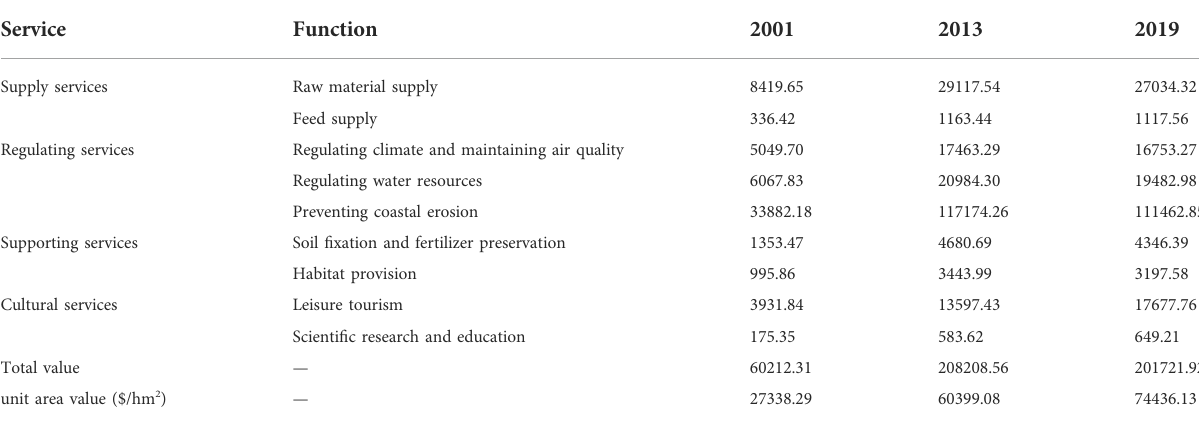
TABLE 3 The monetary values of China ’ s mangrove ecosystem services in 2001, 2013, and 2019 (million $).